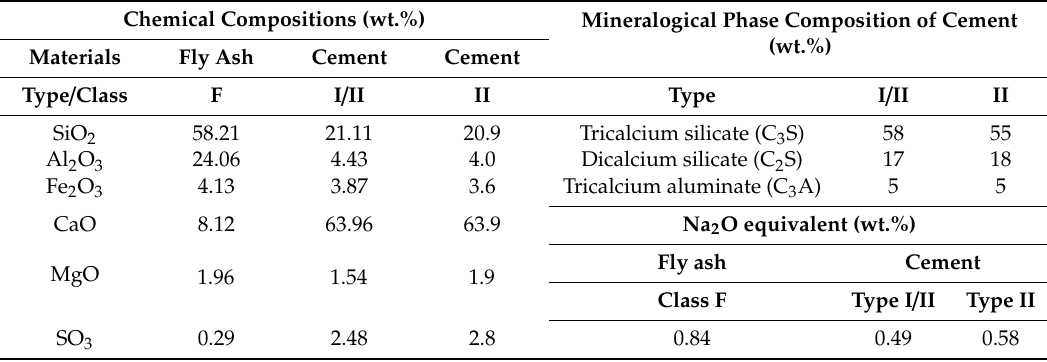
Figure 1. ( a ) Aggregate gradation and ( b ) expansion of Brazos River sand and El Paso sand based on ASTM C1260 (2014). Table 1. Chemical composition of cements and fly ash.